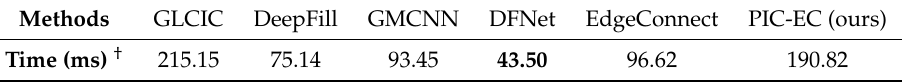
Table 5. The feed-forward inference average computation time comparison for methods: GLCIC,